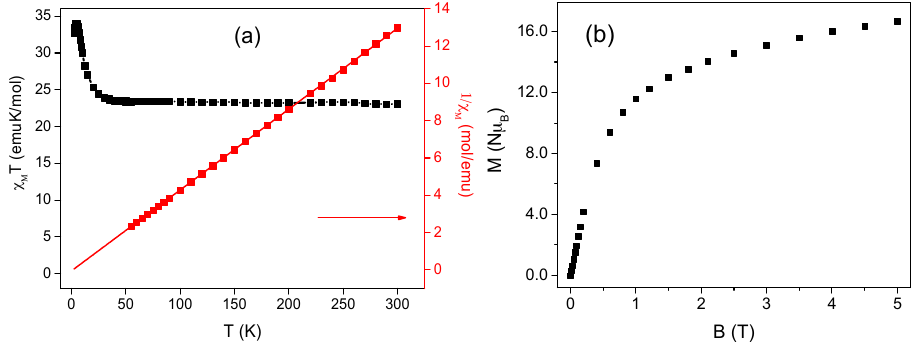
Figure 4. ( a ) The temperature-dependent magnetic susceptibility at 1 kOe of the pure cobalt complex. The red line represents the best fit of the Curie − Weiss law χ M = C/(T − θ ). The parameters are explained in the text; ( b ) Isothermal Magnetization observed at 2.5 K as a function of applied magnetic field.